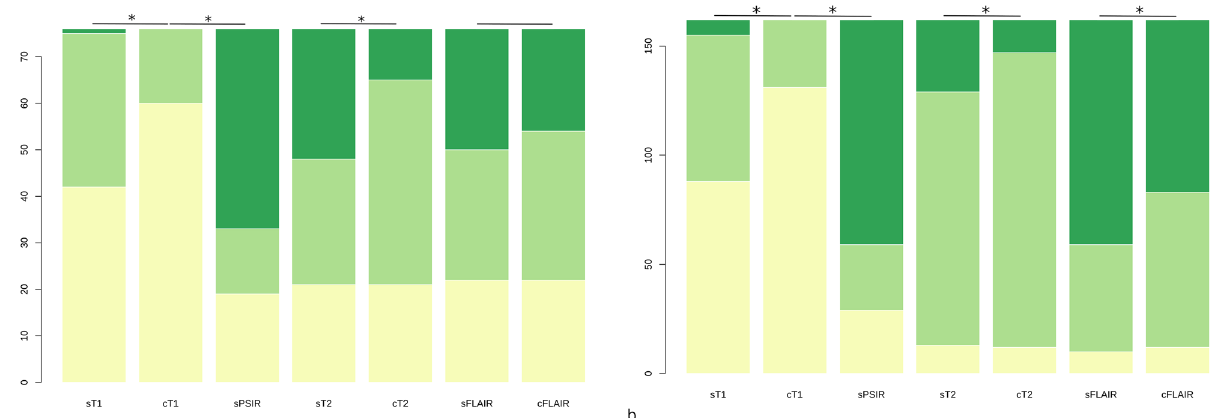
Figure 3. Stacked bar plot of overall image quality for conventional and synthetic MR imaging for ( a ) 46 acute (DWI + /rADC) and ( b ) 90 chronic (WMH) ischemic lesions in the first 25 consecutive patients. Each contrast- weighted image quality for lesion definition and visibility was rated according to a 3-level score by two readers as: 1—no lesion visible (yellow), 2—lesion visible (light green), 3—well-defined lesion (green). Significant differences ( p < 0.05) between weighted images are indicated by an asterisk.